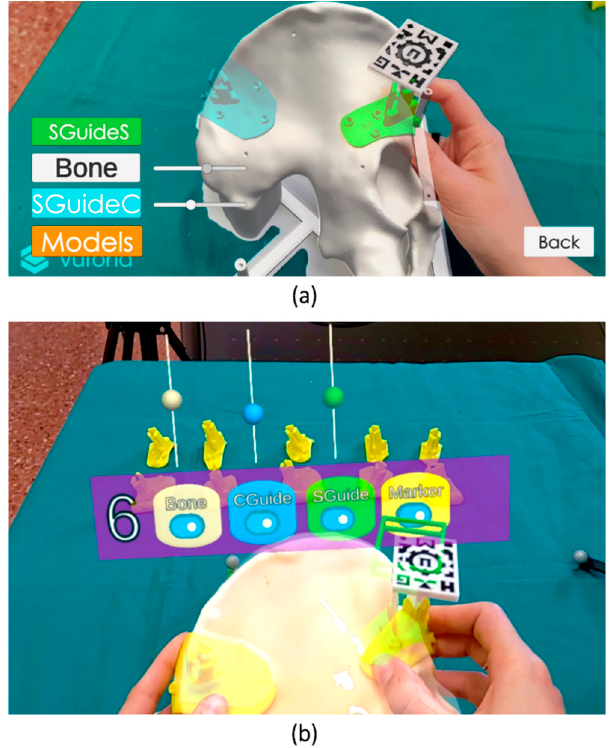
Figure 2. Screenshots of the AR visualization with the ( a ) smartphone and ( b ) HoloLens 2 during PSIs placement. Specific interactive panels of each device are shown, containing visibility and opacity buttons and sliders.